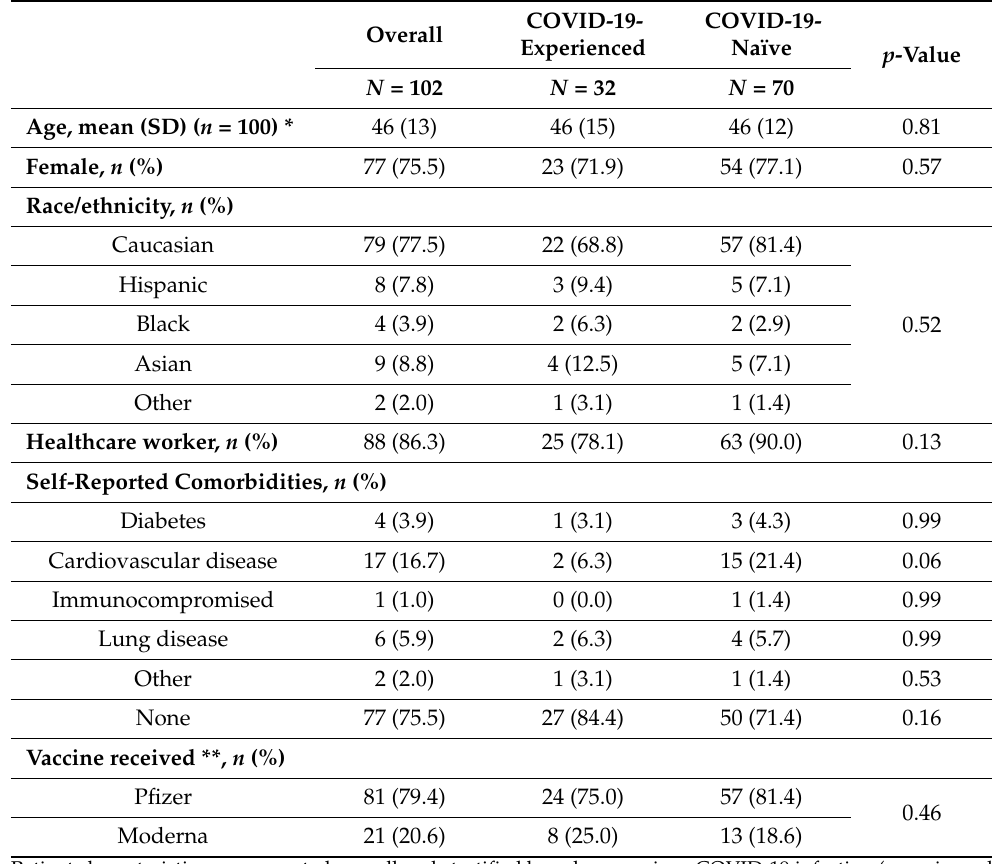
Table 1. Participant characteristics by COVID-19